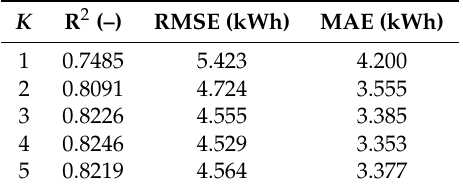
Table 8. Results of different K , where n min = 3 and M = 1000.